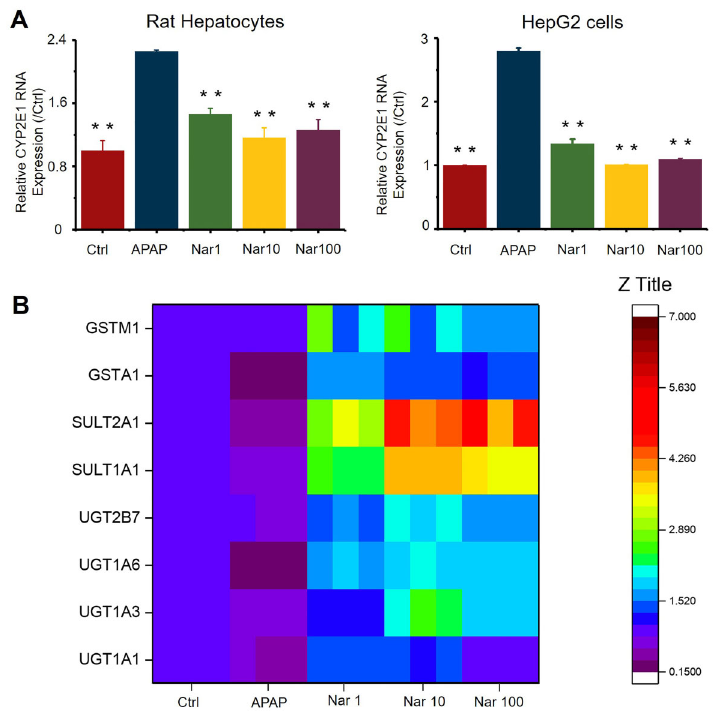
Figure 3. A , RT-qPCR results showed that Naringin (Nar) downregulated the gene expression of CYP2E1 in primary rat hepatocytes and HepG2 cells. B , Nar upregulated phase II enzymes involved in acetaminophen (APAP) metabolism in hepatocytes and in HepG2 cells. Data are reported as means ± SD (n=3). **P o 0.01 vs the APAP group